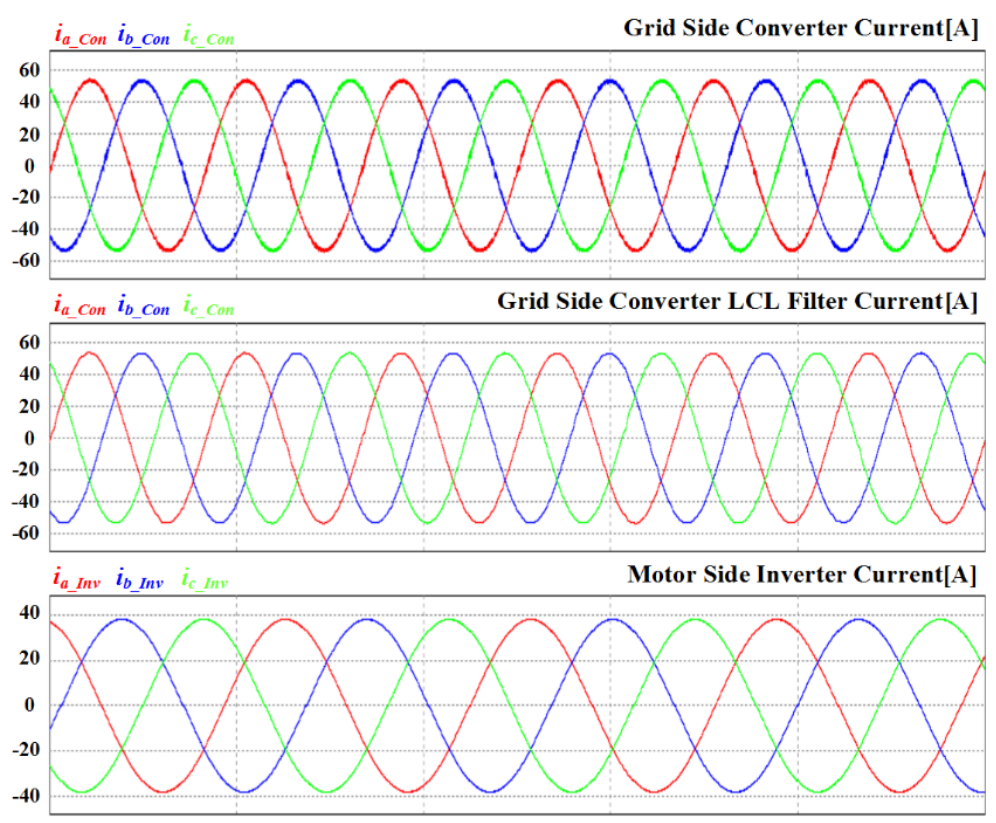
Figure 19. Simulation results of grid side current, LCL filter current and three-phase motor current using the proposed ZDPWM method.